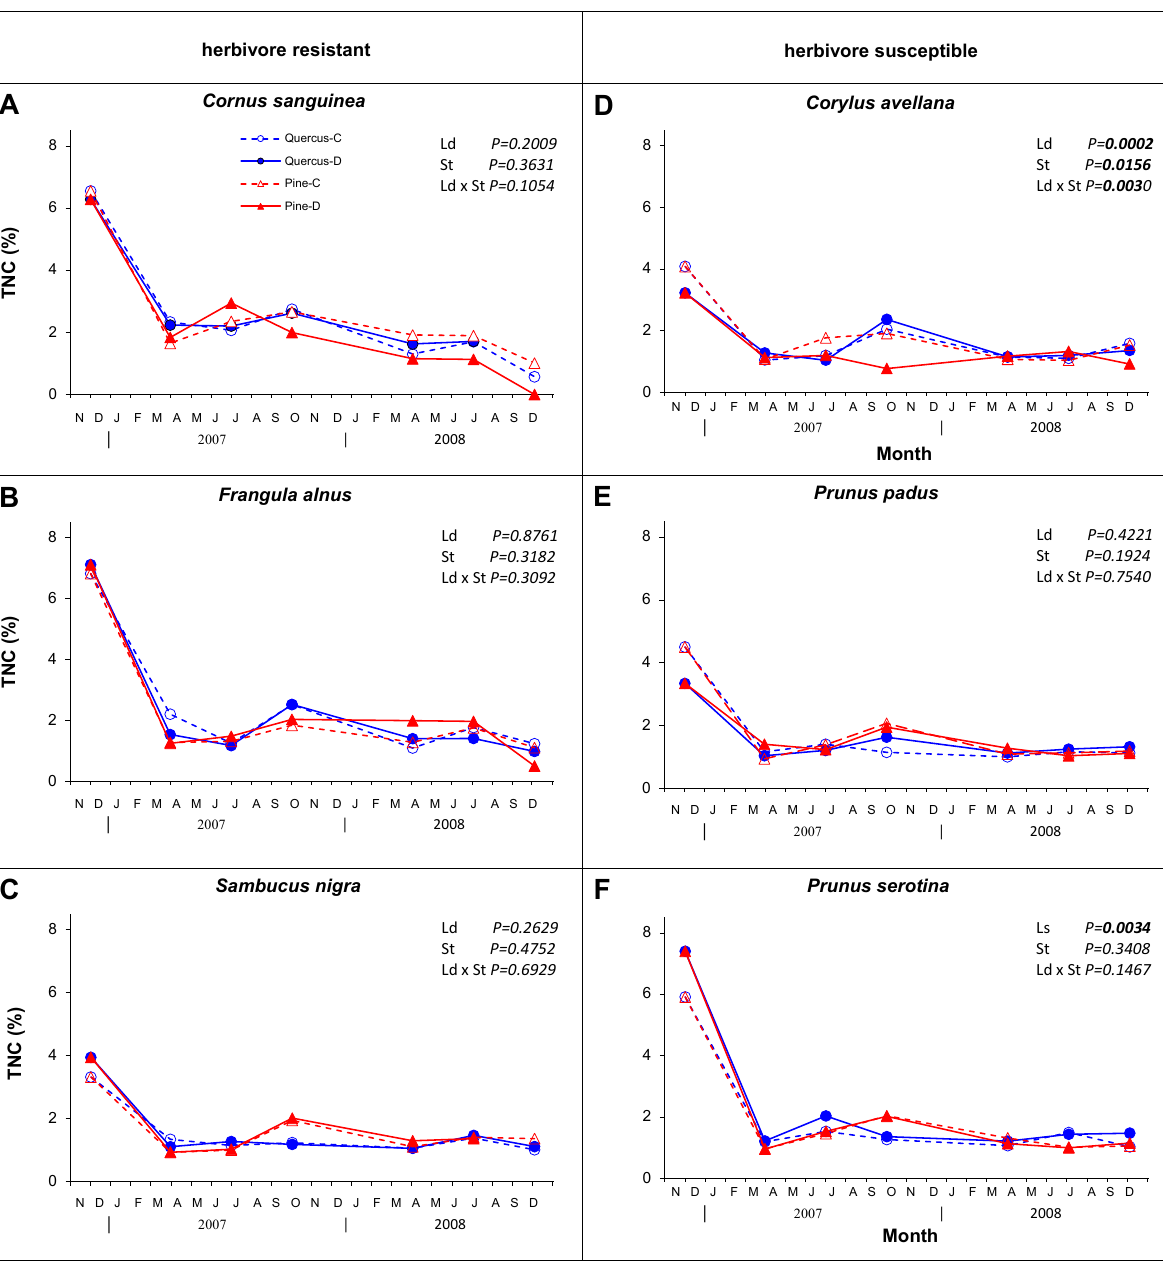
Figure 6. Changes in content of total non-structural carbohydrates (TNC, % d.m.) in leaf litter of six understory plant species (herbivore resistant species: Cornus sanguinea —( A ), Frangula alnus —( B ), Sambucus nigra —( C ), on the left and herbivore susceptible species: Corylus avellana —( D ), Prunus padus —( E ), Prunus serotina —( F ), on the right), depending on leaf damage (Ld; control (C) and damaged (D)) in two stand species (St; oak and pine monocultures).